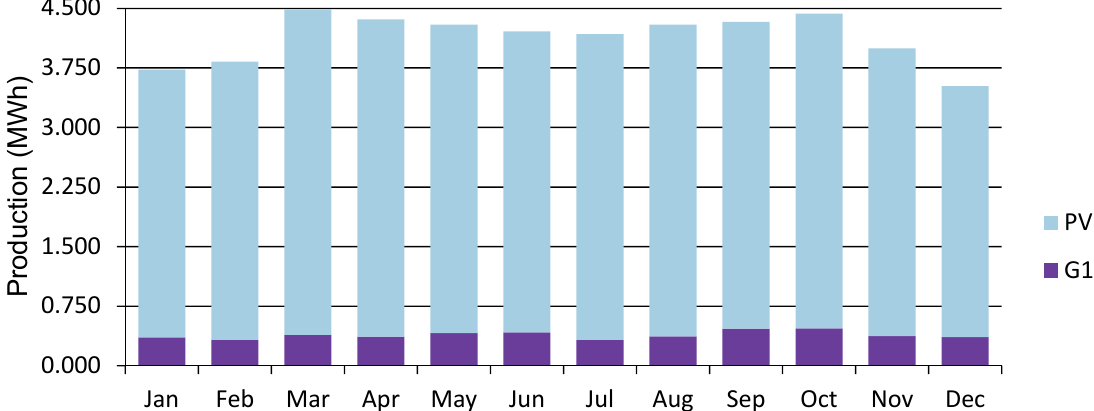
Figure 15. Power generation share at Site 12 (PV represents solar PV generation, and G1 represents wind turbine generation).